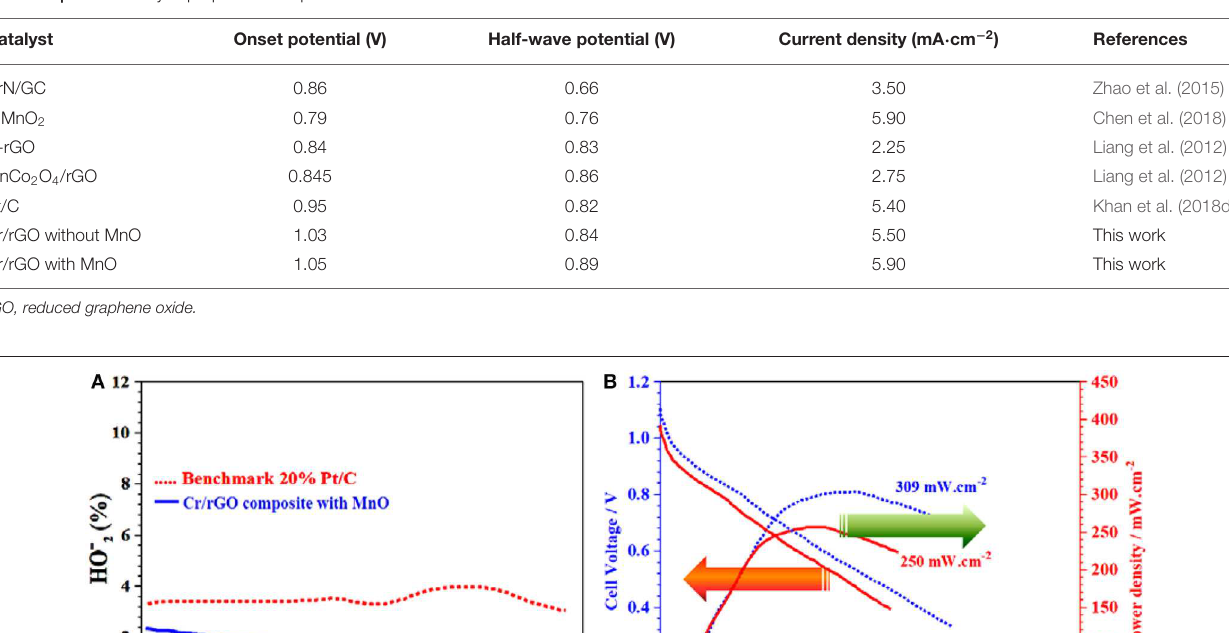
TABLE 2 | Electrocatalytic properties comparison.